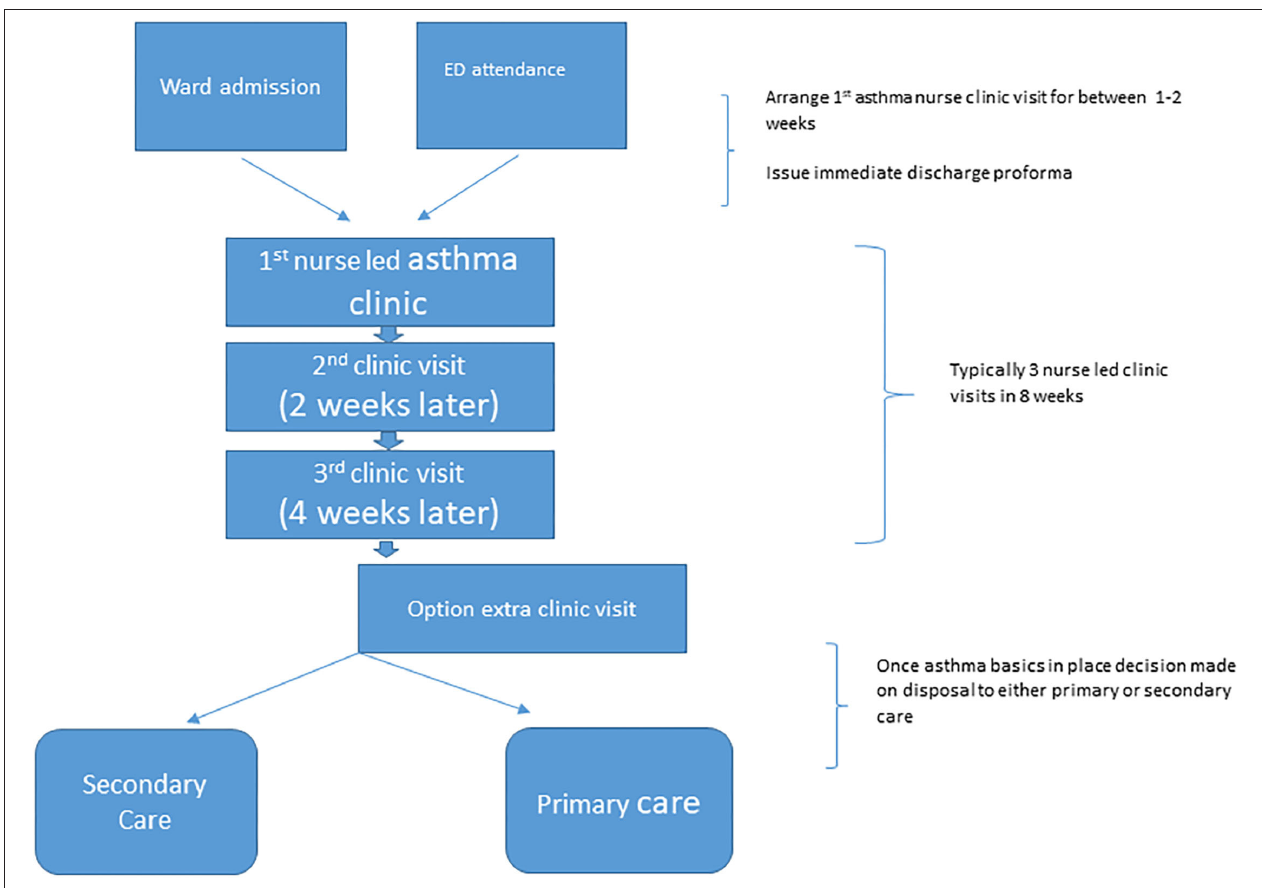
FIGURE 1 | The final SADCP summary